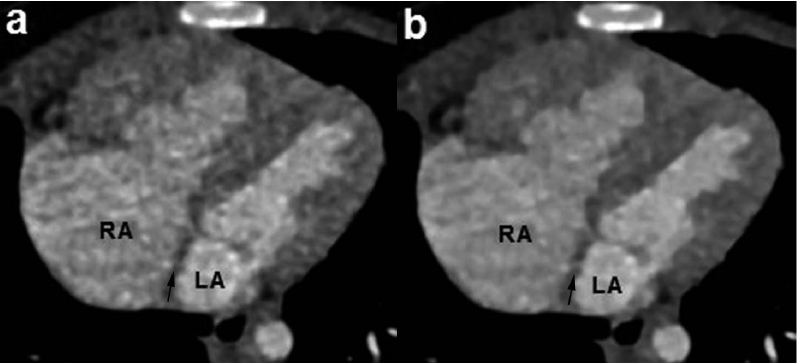
Figure 2. A 7-month girl with a small atrial septal defect. The sequential DSCT angiography was performed with 70 kV and 90 mAs/rotation (effective radiation dose, 0.21 mSv). Multiplanar reformatted (MPR) image reconstructed with sinogram affirmed iterative reconstruction (SAFIRE) algorithm (b) shows the small atrial septal defect (arrow) clearly. However, the lesion was missed on the MPR image using filtered back projection (FBP) algorithm (a). LA = left atrium, RA = right